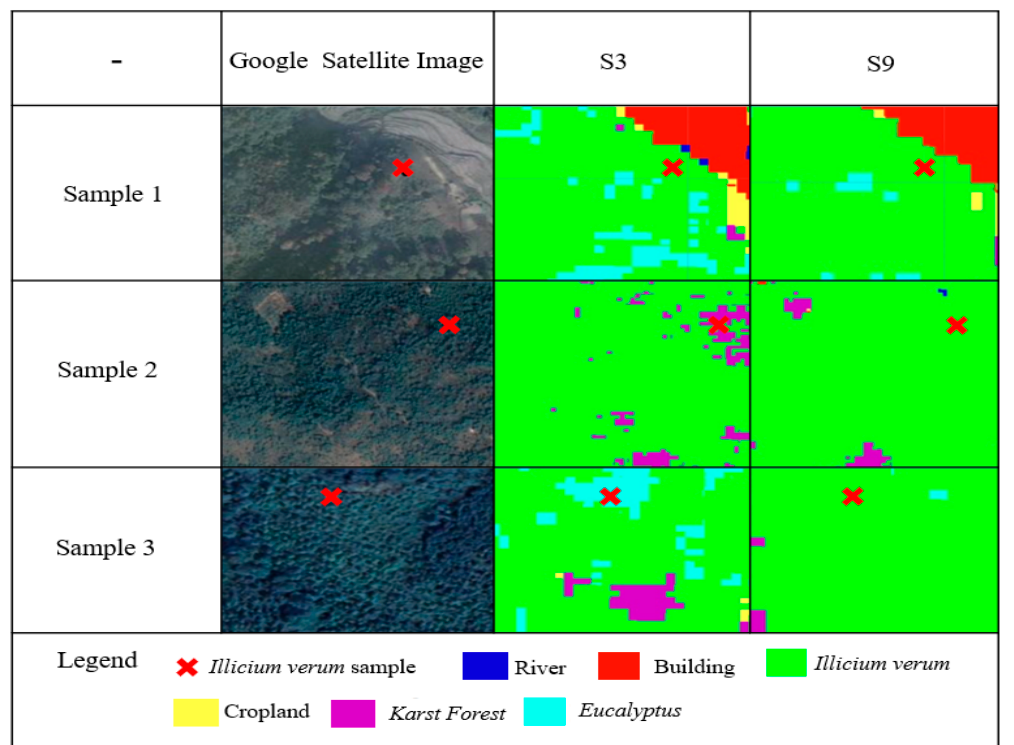
Figure 14. Comparison of Illicium verum extraction details between S3 and S9 with Google Satellite Image.